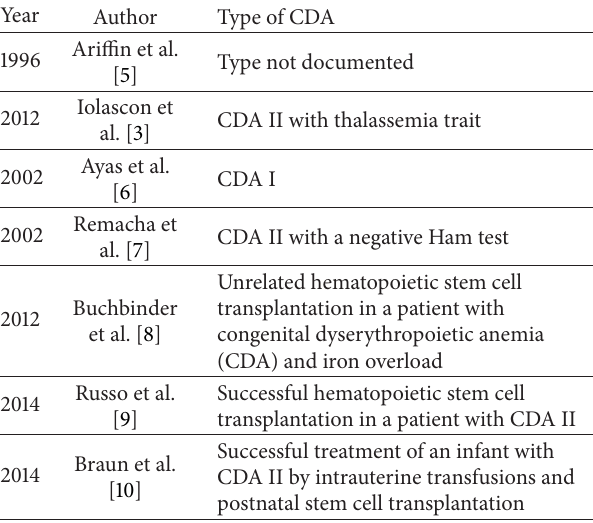
Table 1: HSCT done in various types of